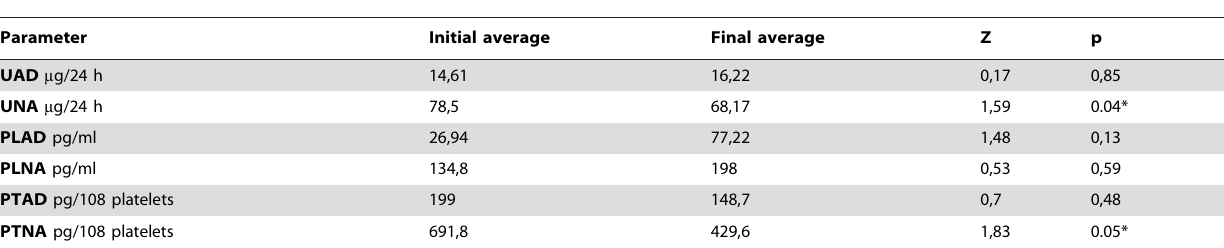
Table 5. Group with one year of treatment with